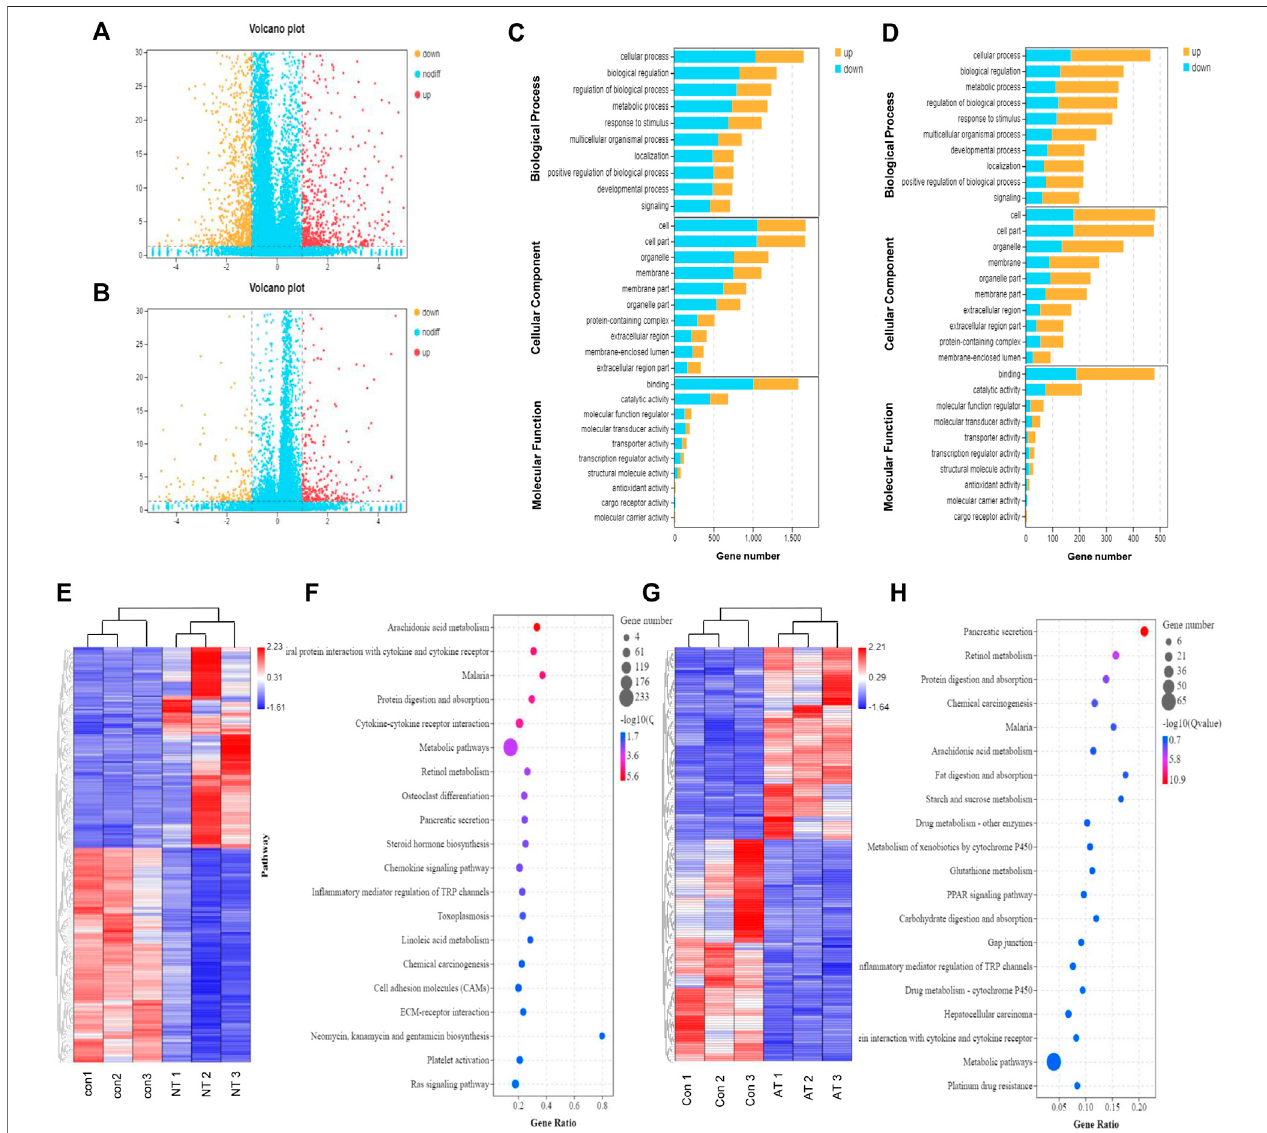
FIGURE 4 | Transcriptomic analysis of AAI-treated neonatal (NT) and adult mice (AT). Volcano graph showed the differentially expressed genes (DEGs) in the NT group (A) and AT group (B) . The red dots represent signi fi cantly upregulated genes, and the orange dots represent signi fi cantly downregulated genes. Enriched GO terms for DEGs in the NT group (C) and AT group (D) . The ontology covered three domains: biological process, cellular component, and molecular function; the Y -axis showsgenefunctions,andthe X -axiscorrespondstogenenumbers.HeatmapdisplayedtheDEGsinthereplicateNTgroup (E) andATgroup (G) comparedtothe CON group. The columns showed the genes that were signi fi cantly upregulated (red) or downregulated (blue) in the different groups. Functional pathway enrichment of DEGs in the NT group (F) and AT group (H) using the KEGG database. (The most enriched top 20 pathway terms).